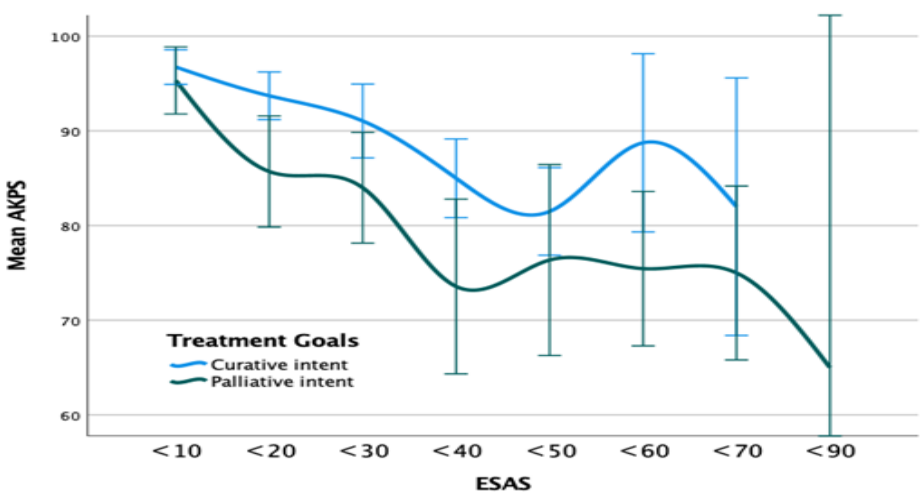
Figure 2. Mean physical function and symptom severity by treatment goals. AKPS: Australia-modified Karnofsky performance scale, ESAS: Edmonton Symptom Assessment Scale.